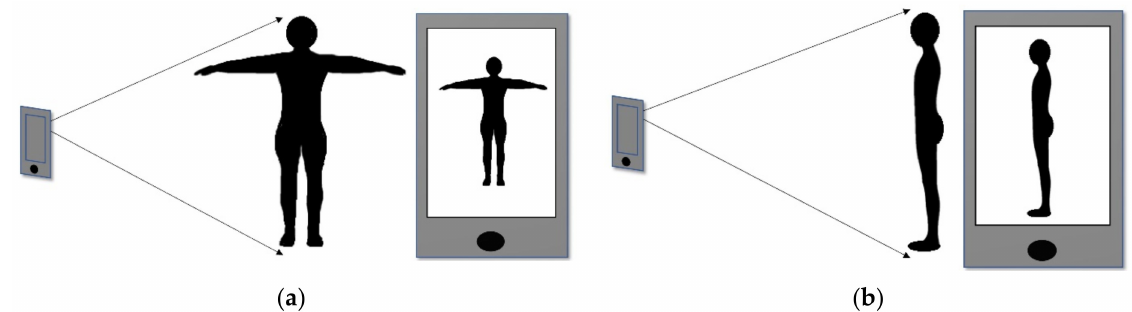
Figure 2. Image capture process with the smartphone from a ( a ) frontal and ( b ) lateral view. The subject is asked to capture the image with their head and toes touching the top and bottom of the camera view,